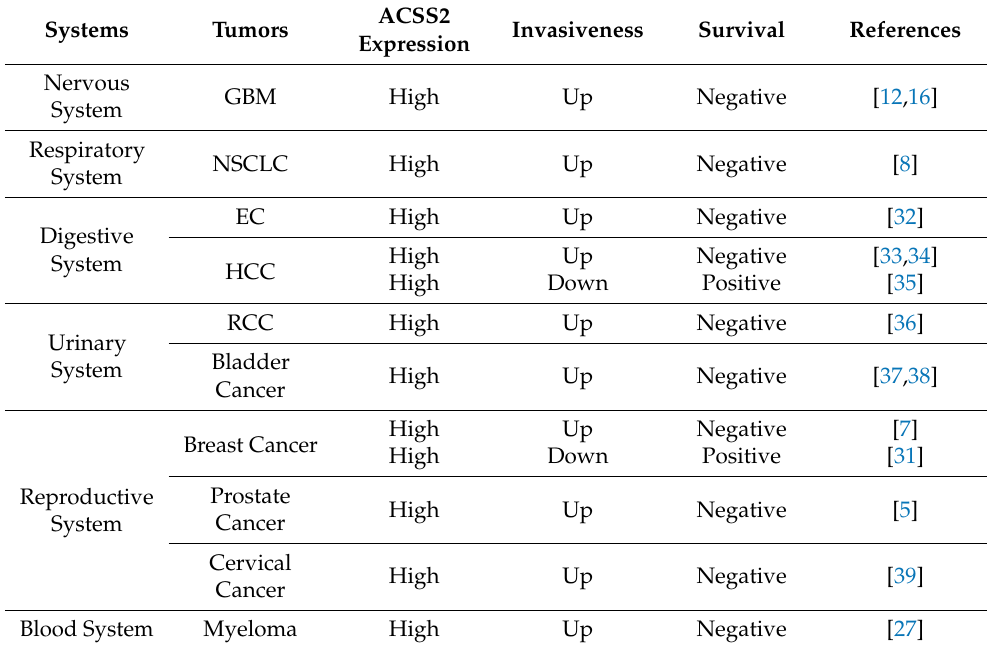
Table 1. The relationship between ACSS2 and tumor invasiveness and patients’ survival